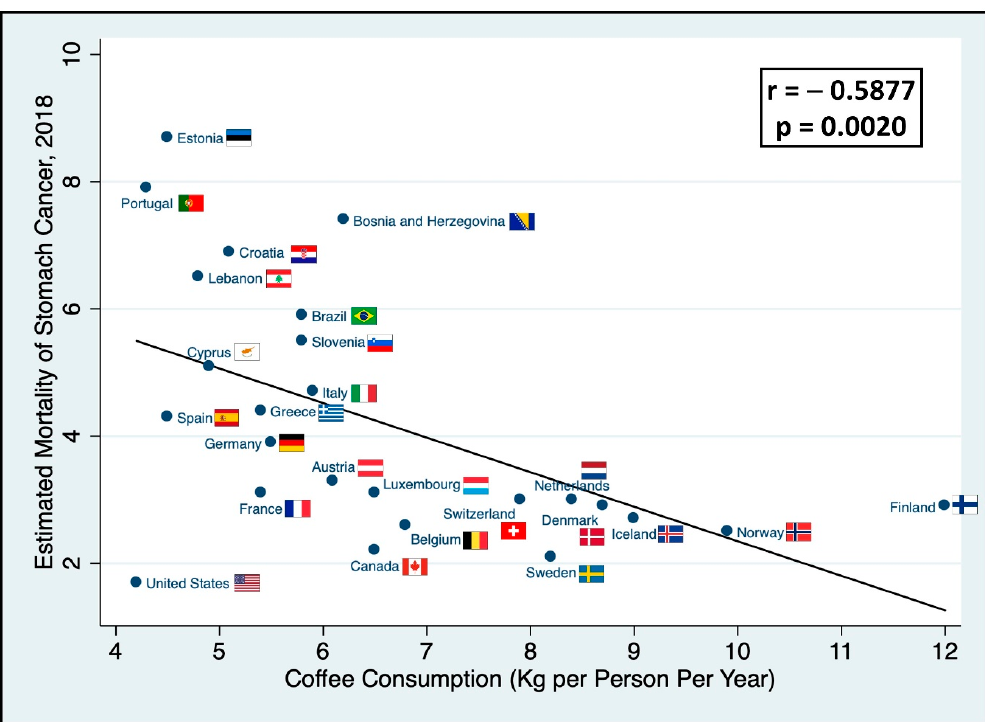
Figure 1. Coffee consumption and stomach cancer incidence. It shows the per country correlation between annual coffee consumption and the estimated age-standardized incidence of stomach cancer in 2018. Lineal model for incidence; incidence of stomach cancer = 10.79–0.69 * (coffee consumption).